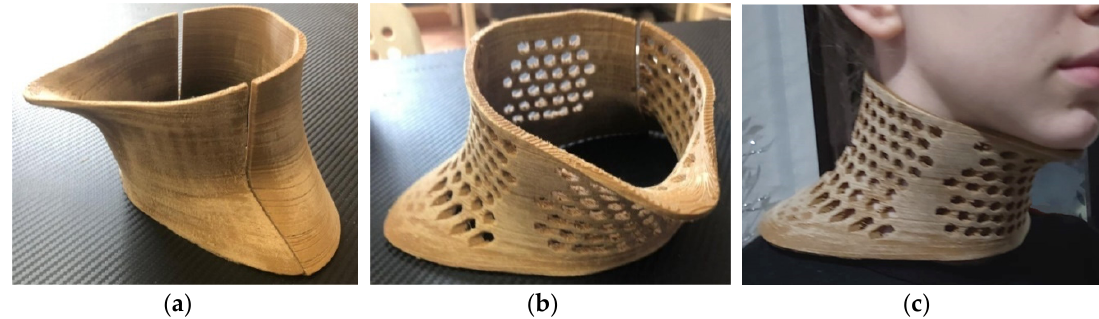
Figure 6. 3D-printed neck orthosis with Hemp filament: ( a ) full model and ( b ) ( c ) model with a pattern of voids.